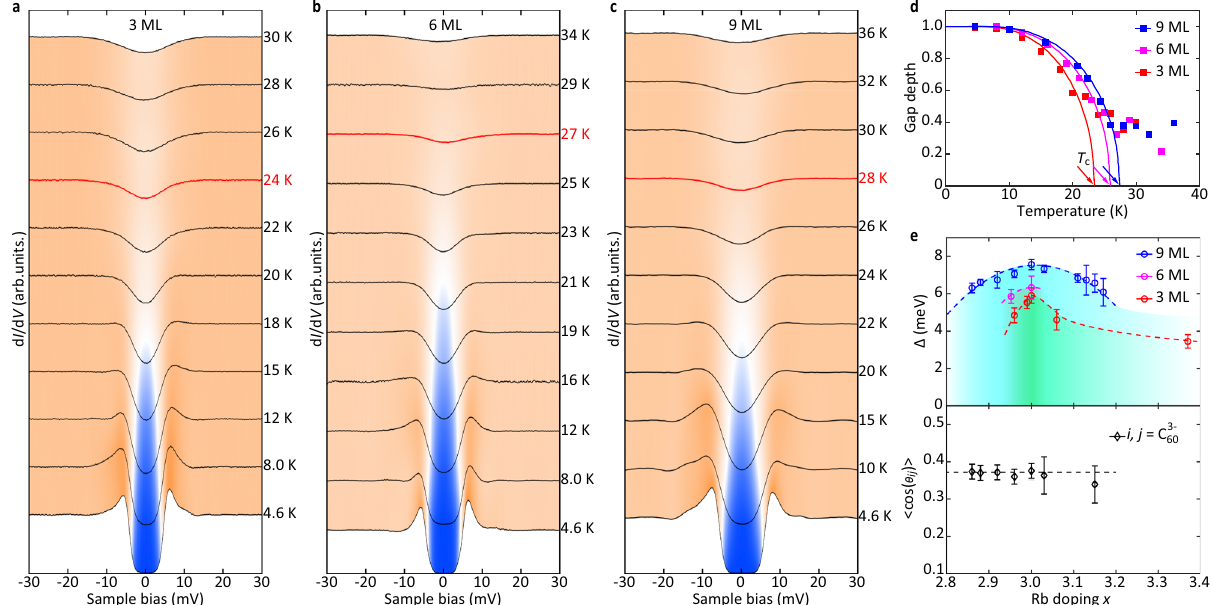
Fig. 2 Thickness dependence of superconductivity. a – c Spatially averaged and normalized conductance d I /d V spectra as a function of temperature and thickness of Rb 3 C 60 fi lms as indicated. The normalization was performed by dividing the raw tunneling spectrum by its background, which was extracted from a cubic fi t the conductance for | V | > 10 mV. Setpoint: V = 30 mV and I = 200 pA. The red curves denote the residual pseudogap justly above the superconducting transition temperature ( T c ). d Dependence of the superconducting gap depth on temperature, yielding a gradual increase of T c with fi lm thickness (see the guided solid lines and arrows). Here the gap depth denotes the difference between unity and the normalized zero-energy conductance. e Electronic phase diagram showing the evolution of superconducting energy gap Δ (empty circles) and averaged orientational correlation (diamonds) as a function of Rb doping x . Note that the orientational correlation function <cos( θ ij )> is only averaged over the trivalent C 60 molecules to minimize any disruption by Rb impurities and excess atoms away from half- fi